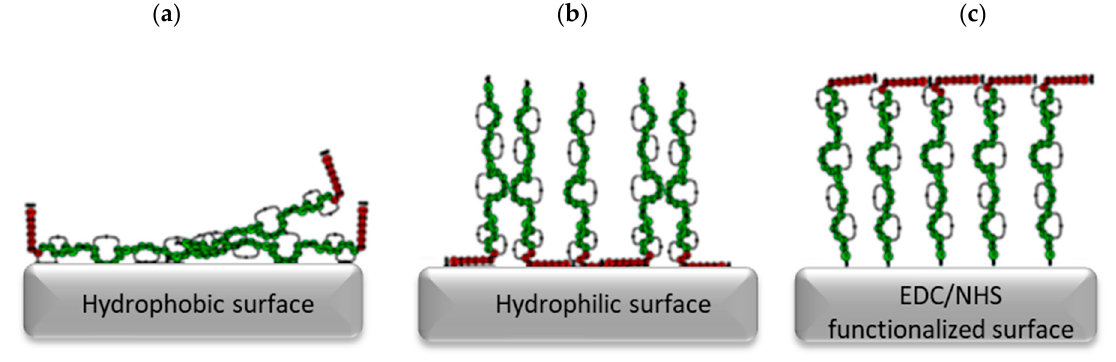
Figure 13. Proposed orientation of nisin on ( a ) hydrophobic surface, ( b ) hydrophilic surface and ( c ) with EDC/NHS functionalized surface (Adopted with permission from [138], RSC, 2017).